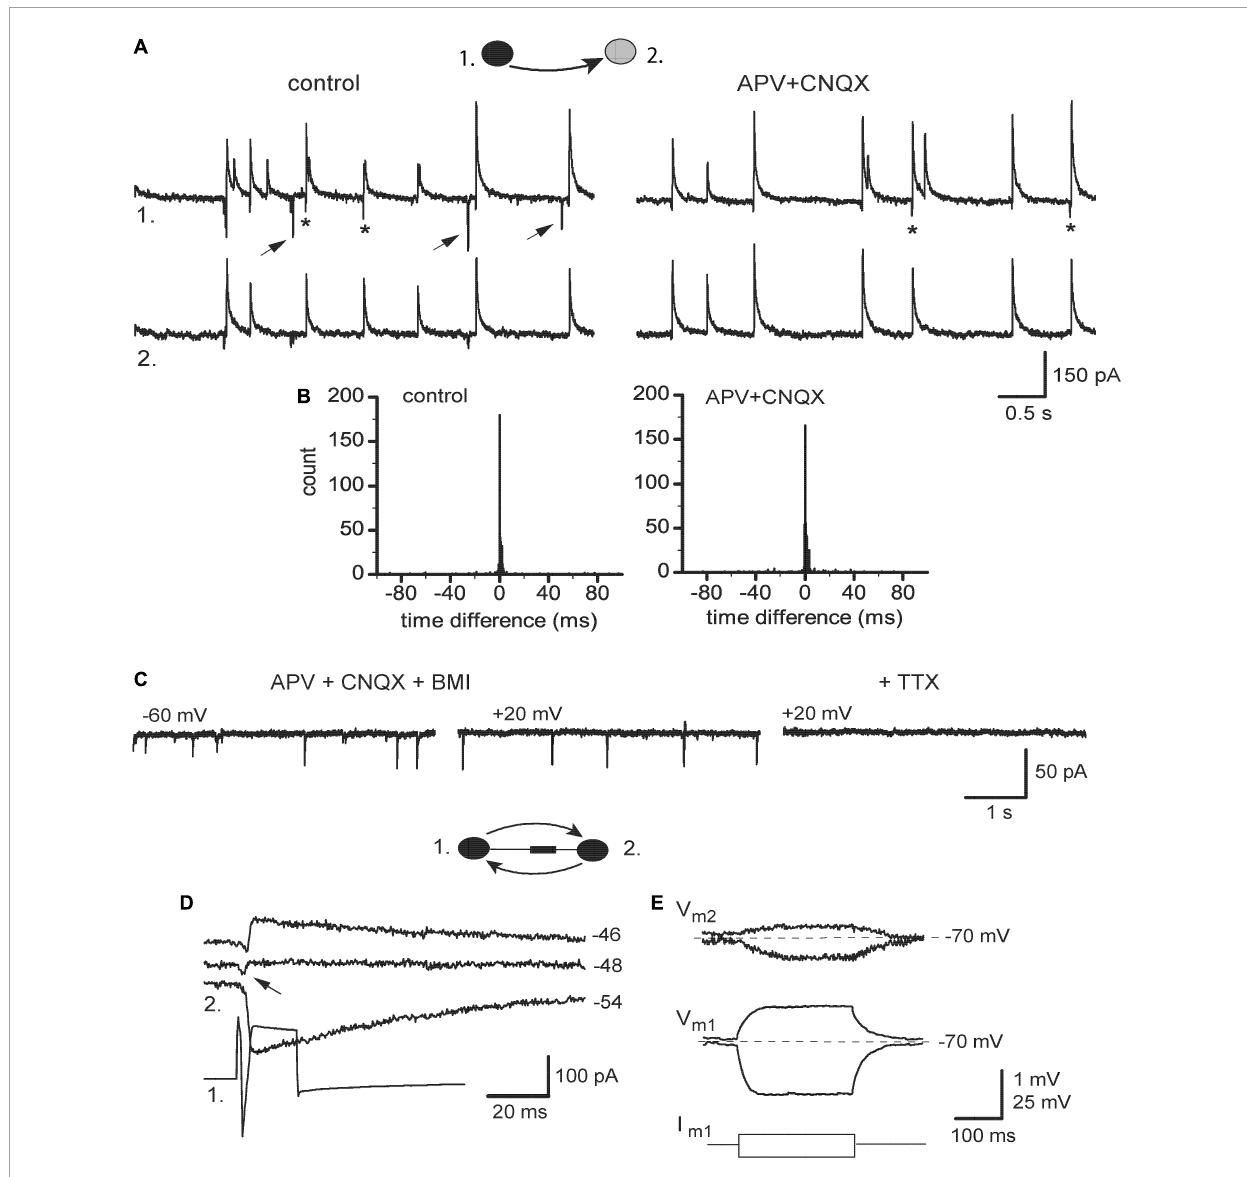
FIGURE6 Expression of electrical coupling in ps-IPSCs weakly dependent on iGluR. (A) Pair recording of ps-IPSCs in control and under 100 µ M APV with 20 µ M CNQX. Some of the random sEPSCs are marked by arrows , and TICs–by stars . (B) Respective time difference histograms. (C) Spontaneous fast transients occurring under blockers of iGlu and GABA A receptors and insensitive to membrane potential, which were then abolished by 0.5 µ M TTX. (D) Combined electrotonic ( arrow ) and GABAergic responses induced by presynaptic stimulation ( 1 ) in postsynaptic cell ( 2 ) in voltage-clamp mode. (E) Current-clamp recordings, depo- and hyperpolarizing voltage responses induced in cell 1 (V m1 ) were passively transmitted to cell 2 (V m1